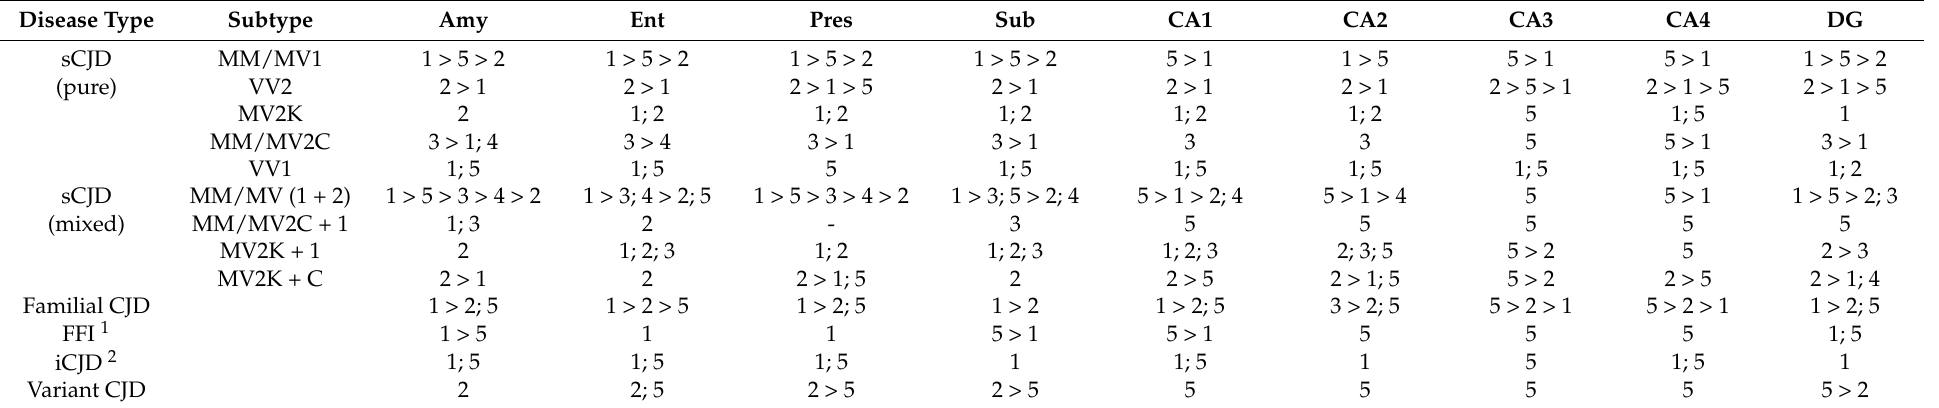
Table 3. Vacuolation pattern observed in assessed areas of the medial temporal lobe in different types and subtypes of human prion diseases included in the patient series. The predominant pattern is shown (code number), followed by less frequent patterns in decreasing order 1 . Numbers separated by “;” represent patterns equally represented in each area. Disease